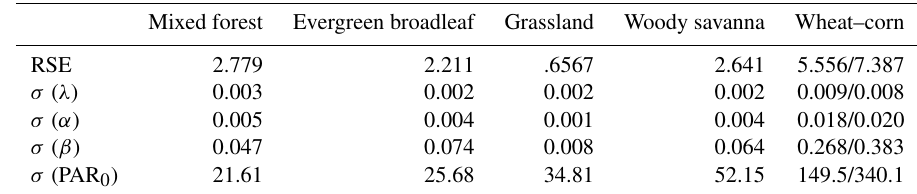
Table 3. Residual standard error and 1 σ values for each calibration site in the study domain.